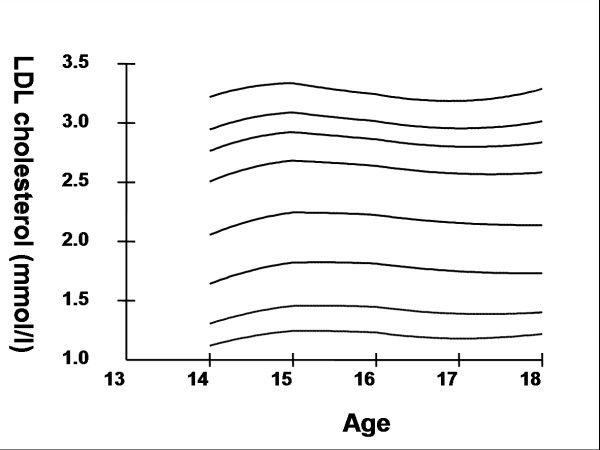
Smoothed percentile curves for the 5th, 10th, 25th, 50th, 75th, 85th, 90th and 95th percentiles of low-density lipoprotein cholesterol for urban girls 14–18 years of age.